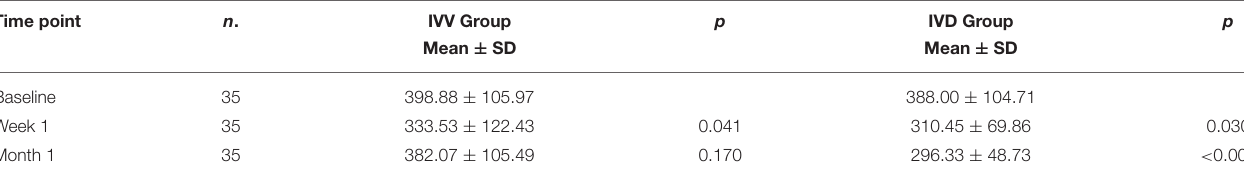
TABLE 3 | Mean CRT ( µ m) at baseline and subsequent time points in the two